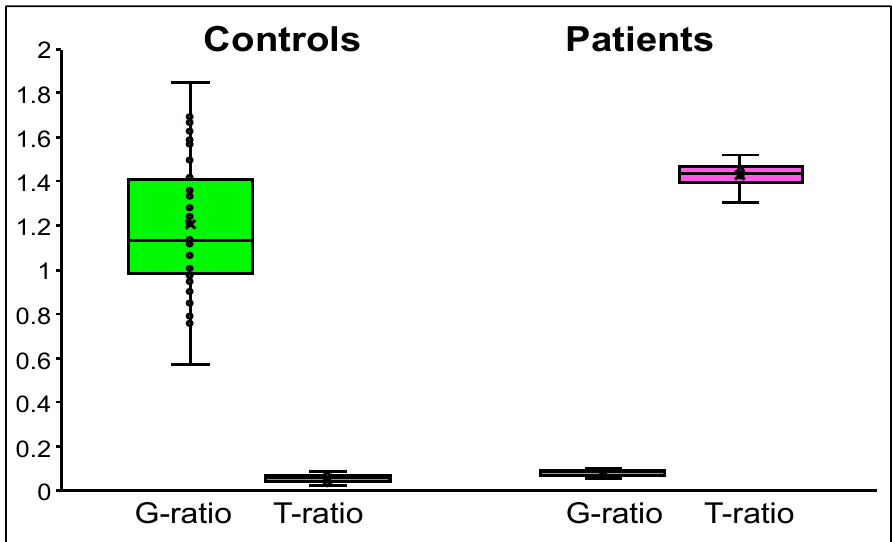
Figure 5. G6PC/CFTR ratio (GCR) values. Box-and-whisker plot of the GCR values from control (green) and patient (pink) groups. The “x” mark represents the average value, the middle line of the box represents the median value, and the lower and upper lines of the box represent the 25th and 75th percentiles, respectively. Table 1. Mean values of the peak height ratios.